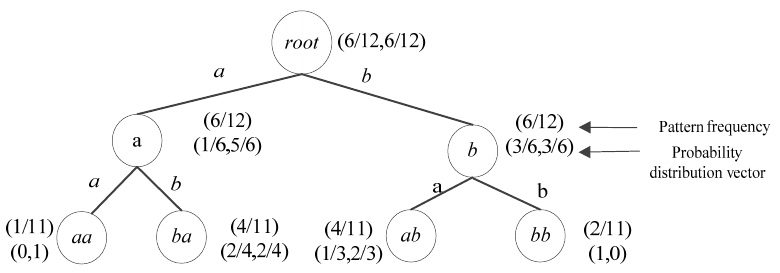
Figure 3. wPST representation for “ abbabbabaaba ” .